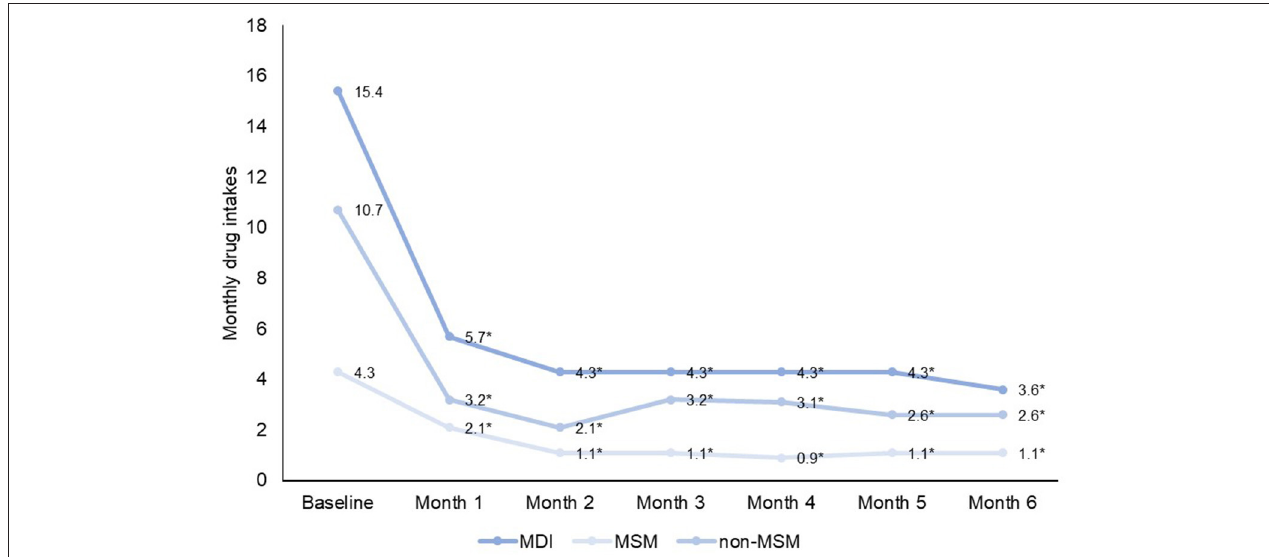
FIGURE 1 | Median Monthly drug intakes (MDI), non-migraine specific medication (NMSM) intakes, and migraine specific medication (MSM) (MS medication) drug intakes. * p ≤ 0.001 compared to baseline for all variables.